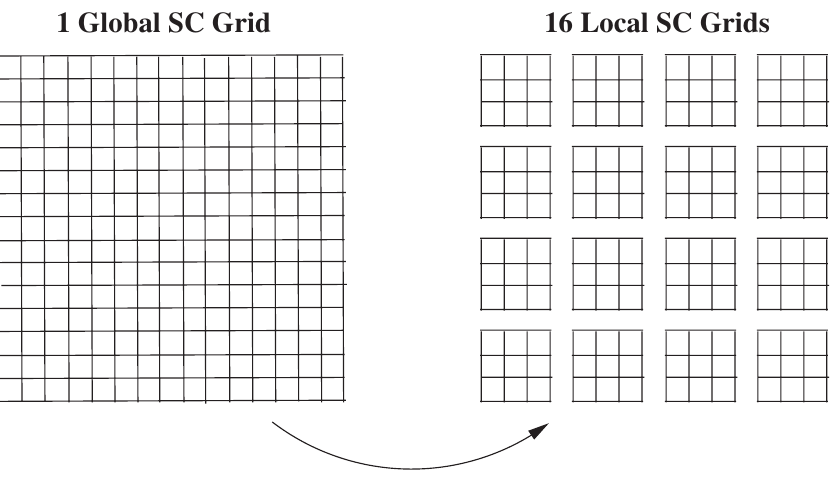
FIG. 7. Example: 2D decomposition of a 16 (cid:3) 16 (cid:3) N shown because it is not affected by this